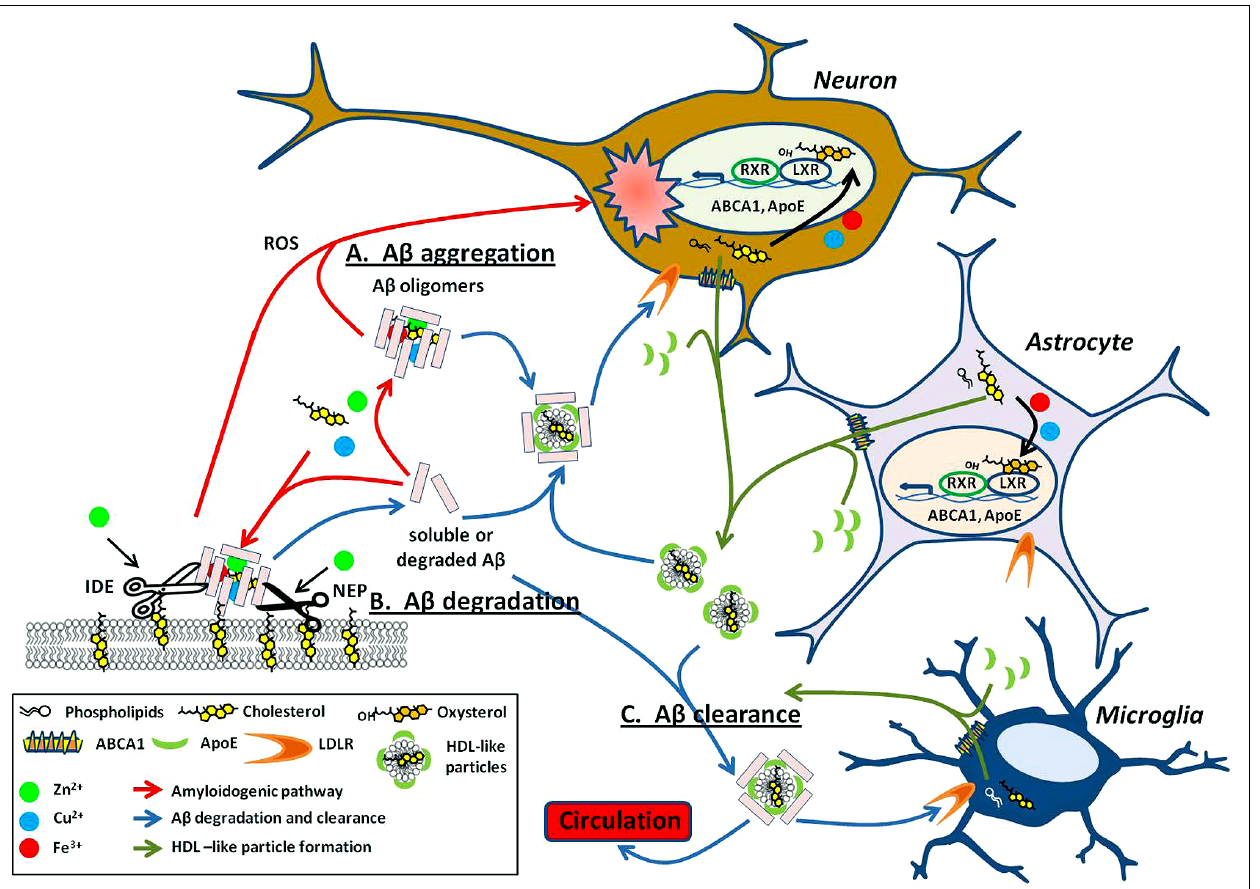
FIGURE 2 | Metals and cholesterol implicated in A β processing and neurotoxicity. (A) Upon cleavage from APP, both metal and cholesterol bind to A β monomers promoting oligomerization of the peptide into multiple types of A β aggregates. These aggregates are either present within the extracellular space or bound to the surface of the plasma membrane ( red arrows ). Select A β aggregates are neurotoxic through multiple mechanisms such as their ability to generate reactive oxygen species (ROS) and may have implications in AD associated neuropathology. The ability of copper, iron, and cholesterol to promote redox cycling are acutely involved in the cytotoxicity caused by aggregated A β . (B) As with APP processing enzymes ( Figure 1B ), proteases that degrade A β , such as neprilysin (NEP) and insulin degrading enzyme (IDE) are dependent on metals for their catalytic activity. These proteases are also lipid raft associated and modulated by cholesterol levels in these domains. (C) Lipidated ApoE,